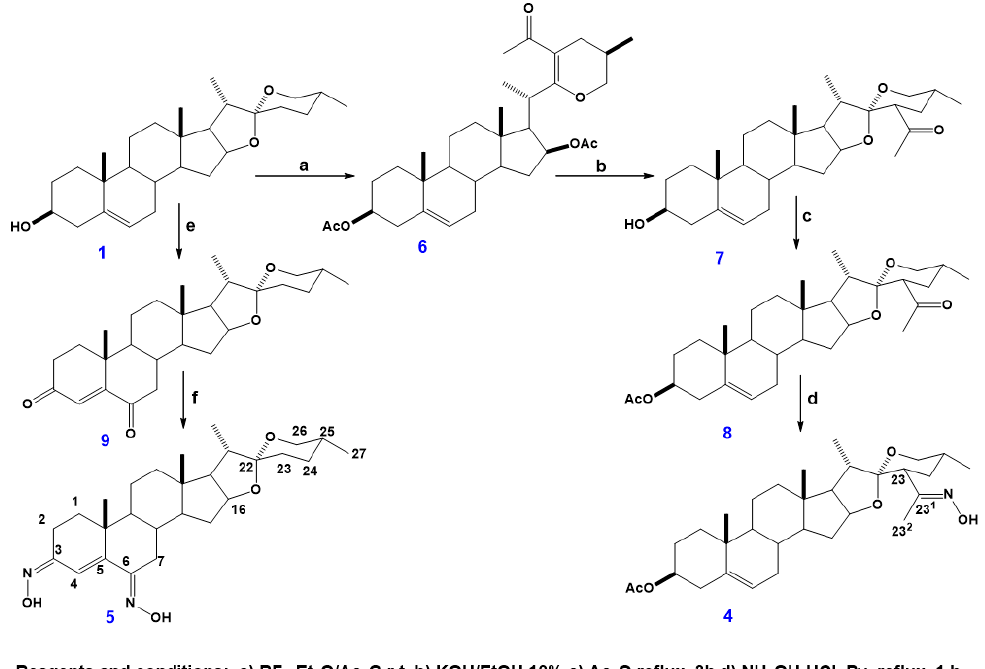
Scheme 1. Synthesis of oxime of (23 R )-acetyldiosgenin acetate ( 4 ) and dioxime of (25 R )-spirost-4-en- 3,6-dione ( 5 ).